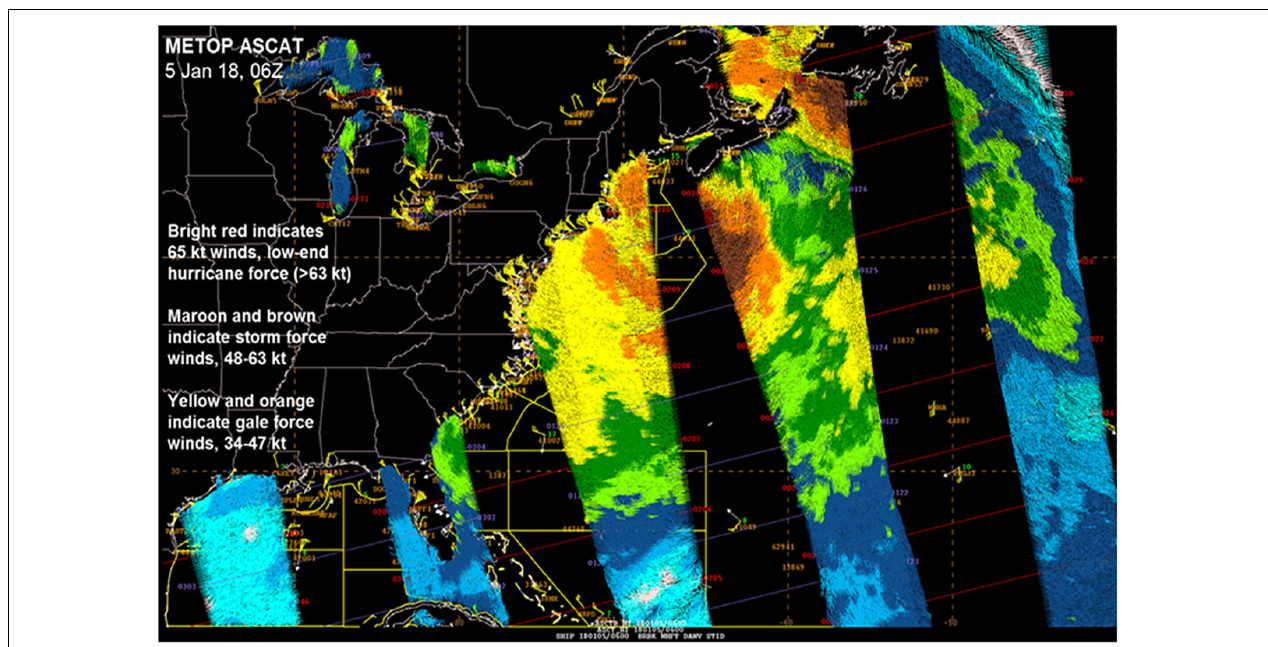
FIGURE 1 | EUMETSAT MetOp Advanced Scatterometer data (colored swaths), with available ship observations (using standard synoptic station notation), from 0600 UTC on 5 January 2018. Courtesy of National Oceanic and Atmospheric Administration, National Weather Service, Ocean Prediction